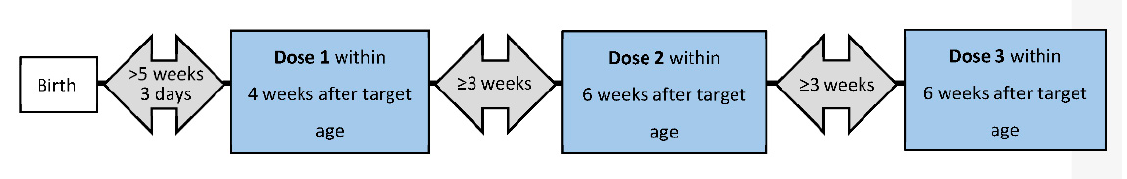
Figure 2. Fully vaccinated criteria.